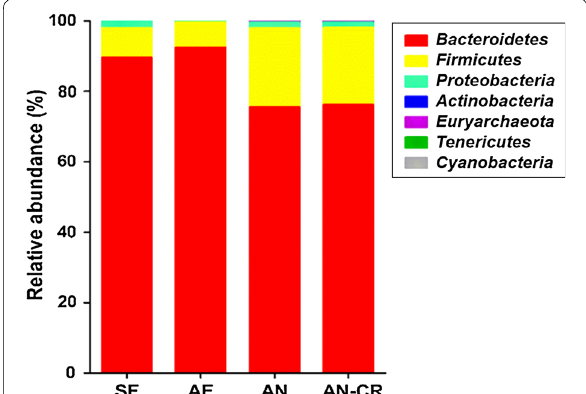
Fig. 4 The average relative abundance of active microbial phyla in all groups. SF sows’ fecal group, AE aerobic group, AN anaerobic group, AE-CR anaerobic-cryopreserved